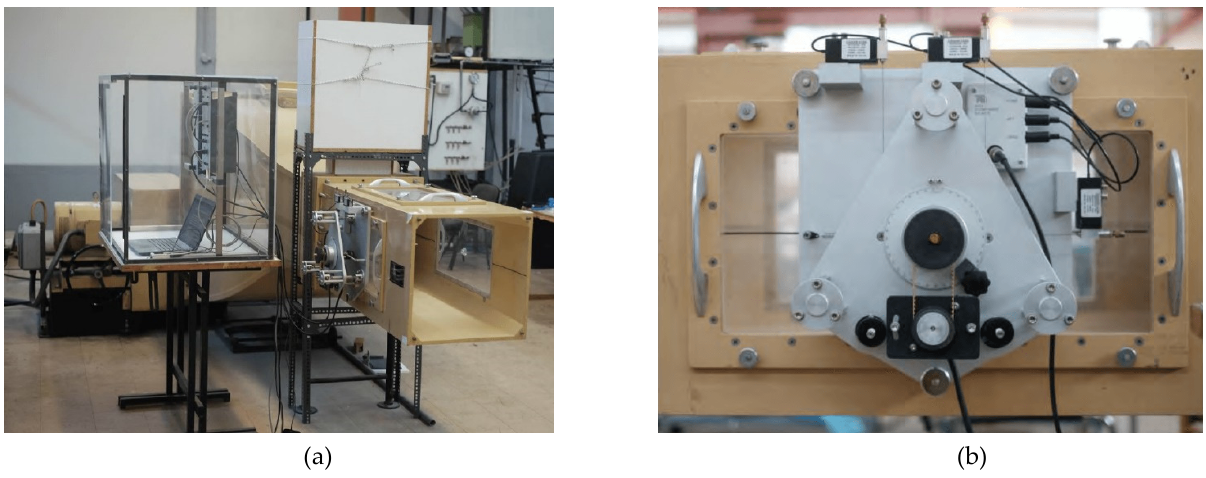
Figure 7. ( a ) Subsonic wind tunnel at Fluid Mechanics Laboratory, University of Patras ( b ) Three- components AFA3 aerodynamic balance, at Fluid Mechanics Laboratory, University of Patras.